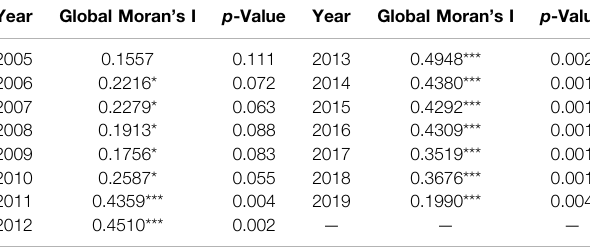
TABLE 4 | Global Moran ’ s I values of the CEA